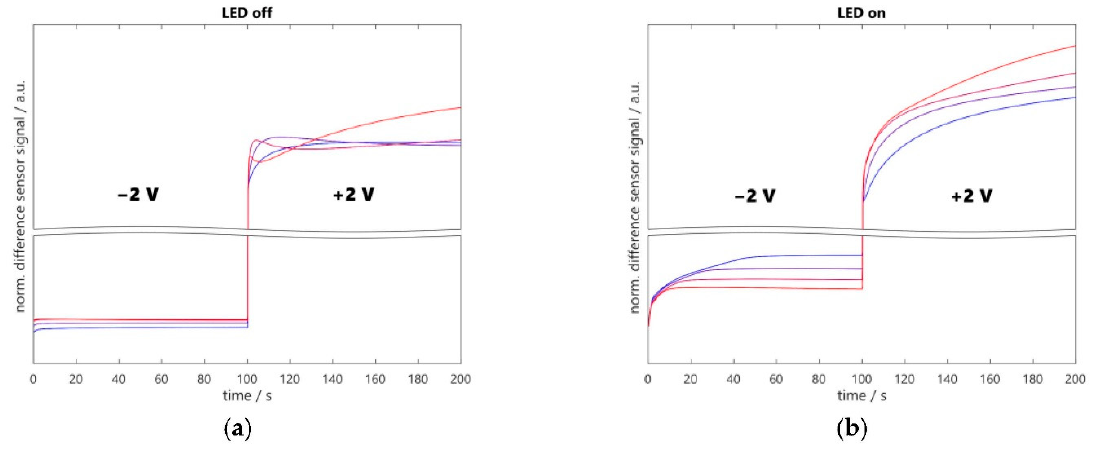
Figure 1. Normalized raw signal in air over time ( a ) without and ( b ) with UV irradiation for four different temperatures (blue 225 °C, red 300 °C). Note that the break and axis limits of the y-axis were chosen such that the upper and lower parts of the diagram have the same scaling, but not necessarily the same